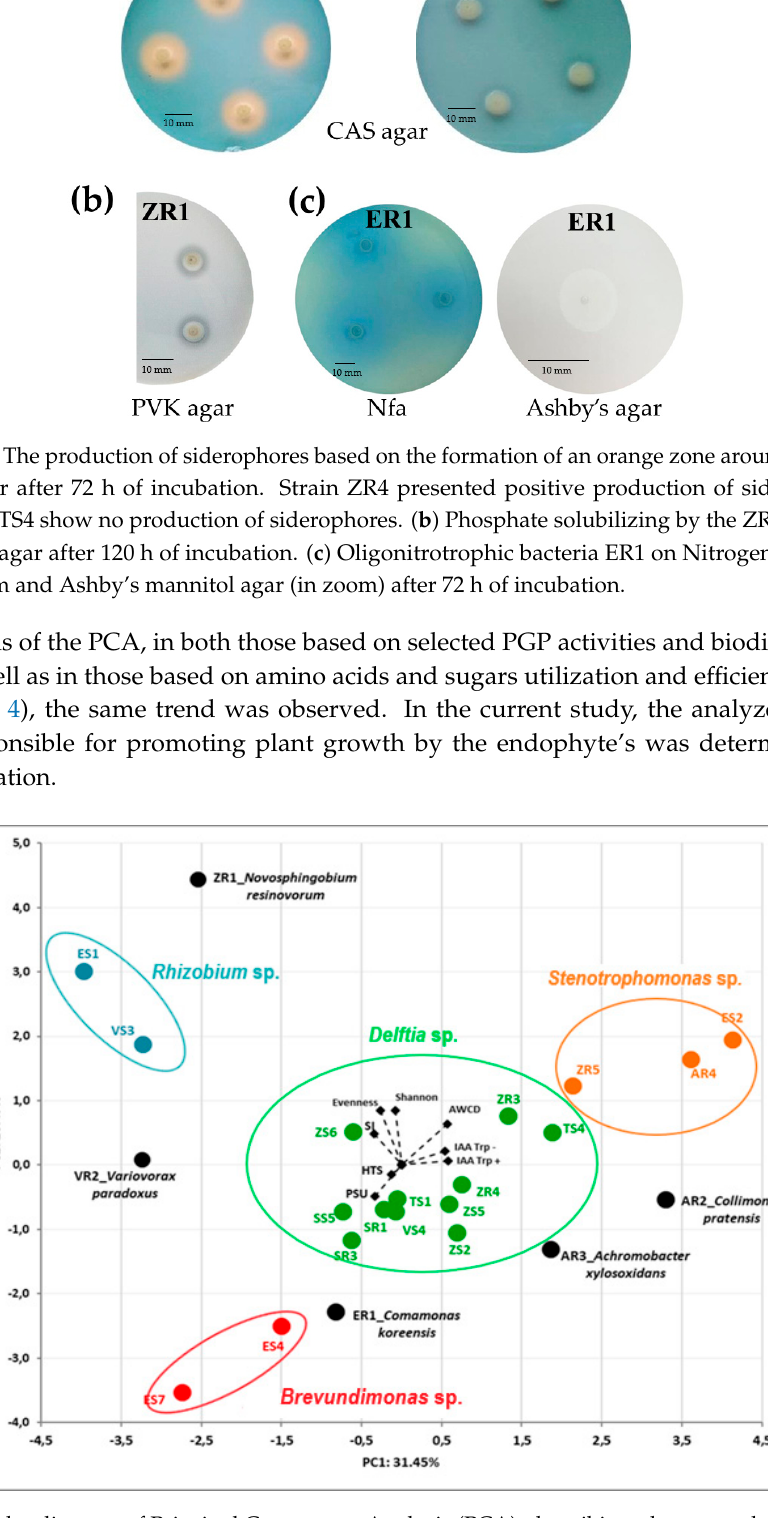
Figure 3. Biplot diagram of Principal Component Analysis (PCA), describing plant growth-promoting activities (IAA, HTS, PSU, SI) and biodiversity (Biolog GEN III) indices (AWCD, Shannon, Evenness) of 23 bacterial endophytes isolated from plants. Strains classified based on the nucleotide sequence of their 16S rRNA genes to the same genus are indicated in different colors.